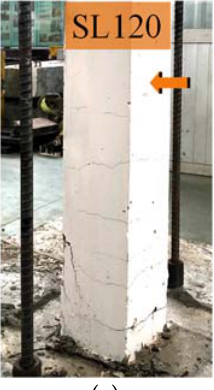
Figure 4. Static test results. ( a ) Flexural failure mode; ( b ) Load ‒ displacement curves. Table 3. Results of static tests.